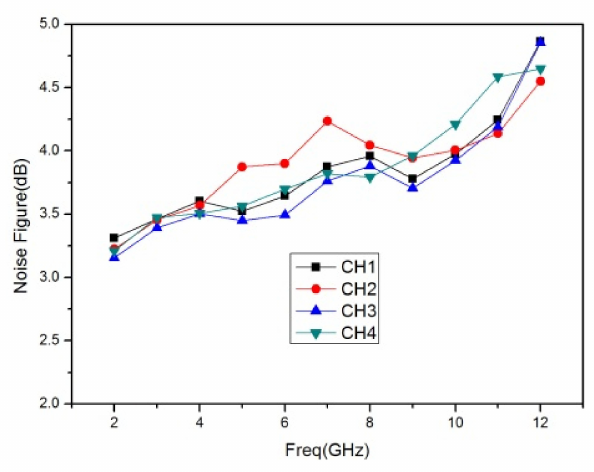
Figure 15. Noise